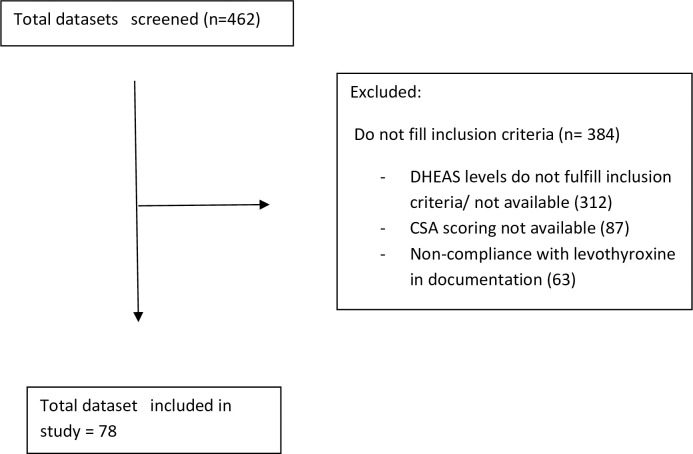
Study flow chart.Of total 462 datasets screened, 78 datasets were included in present study.